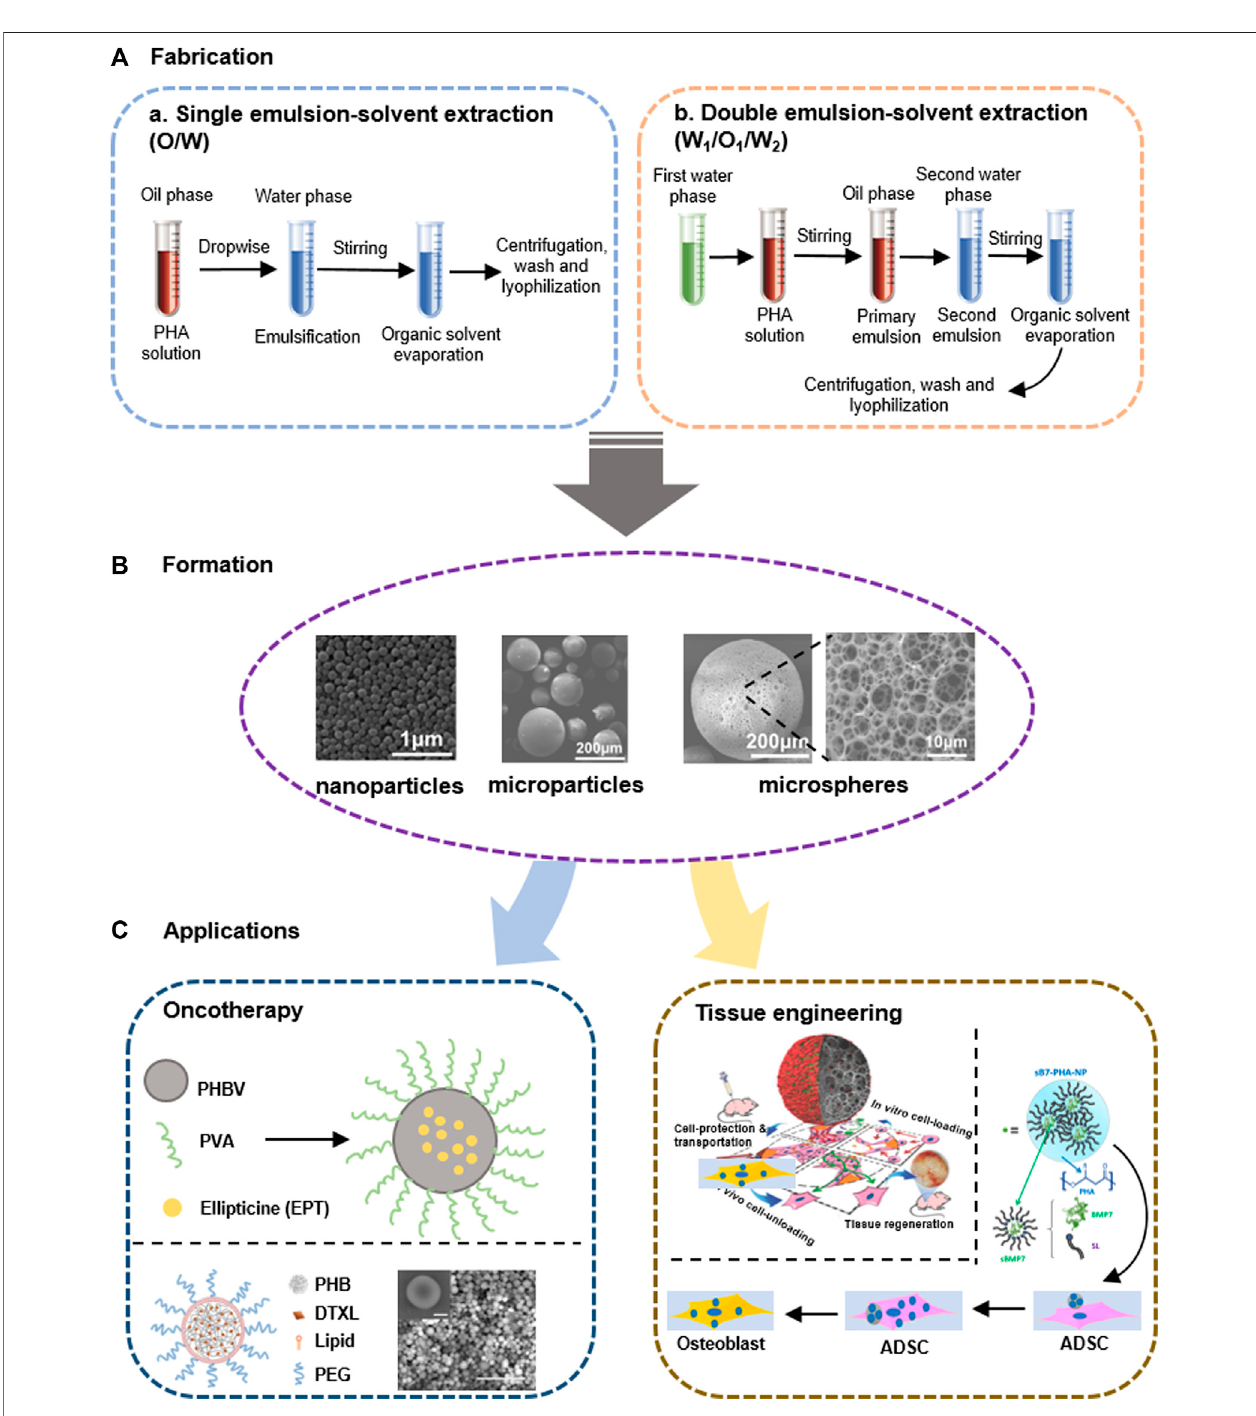
FIGURE 3 | Fabrication and applications of PHA-based particles including micro-/nanoparticles and microspheres. (A) and (B) Fabrication methods of polymeric particlesbasedonsingleanddoubleemulsion-solventextractionmethods,respectively. (C) TherapeuticapplicationsofPHAparticlesloadedwithanti-cancermolecules ellipticine (EPT) and docetaxel (DTXL) for oncotherapy, as well as stem cells and growth factors like Bone Morphogenetic Protein 7 (BMP7) for tissue engineering. Abbreviations: PHBV, poly (3-hydroxybutyrate- co -3-hydroxyvalerate); PVA, polyvinyl alcohol; PHB, poly (3-hydroxyalkanoate); PEG, polyethylene glycol; ADSC, adipose-derived mesenchymal stem cell. Regenerated from (Di Mascolo et al., 2016), (Wei et al., 2018a) and (Chen et al., 2020) with permission.